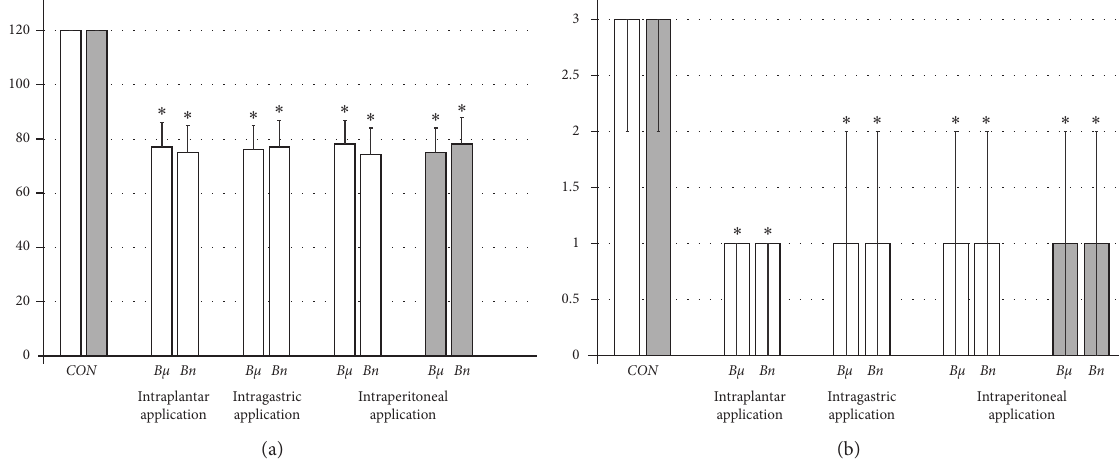
Figure 2: Hot plate test: lidocaine intraplantar (4mg/kg, 0.1ml/foot) application produced complete anesthesia (left) and considerable plantar damage (right) ( CON ). Therapy effect: BPC 157 medication (10 μ g/kg ( Bμ ), 10ng/kg ( Bn )) applied immediately after lidocaine (white bars), as an intraplantar , intraperitoneal, or intragastric application in each foot, considerably counteracted local anesthesia and ameliorated posthot plate test-induced plantar presentation (middle). Prophylactic effect: BPC 157 medication (10 μ g/kg ( Bμ ), 10ng/kg ( Bn )) applied intraperitoneally at 5 min before lidocaine (gray bars) considerably counteracted local anesthesia and ameliorated posthot plate test-induced plantar presentation (right). (a) Hot plate test, time with no pain reaction, sec. (b) Hot plate test-induced plantar oedema, scored 0–3; values are presented as mean ± SD and min/med/max. ∗ P < 0 . 05 at least vs .